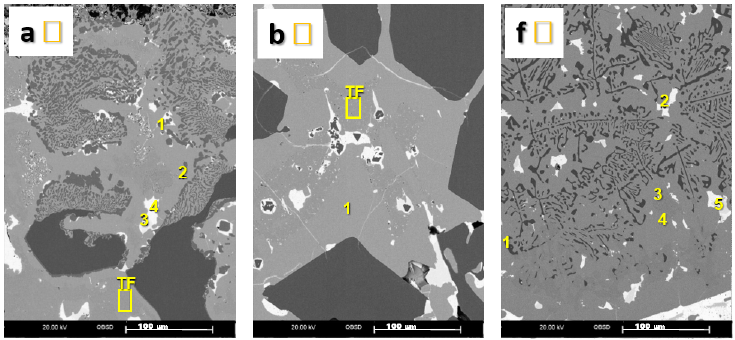
Figure 15. Enlarged sections of Figure 14a,b,f. TF = partial area, as seen in Table 5.